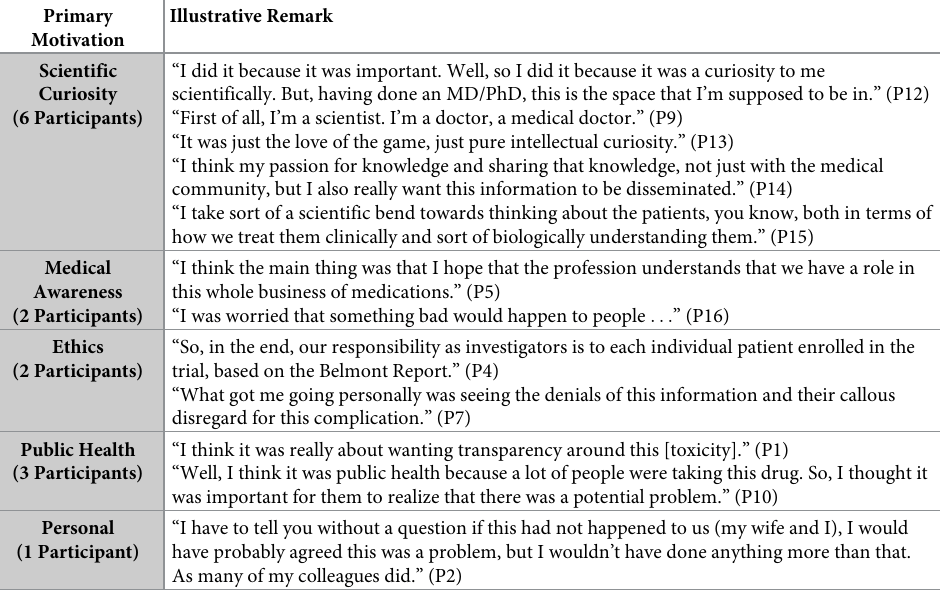
Table 2. Primary motivations for publishing adverse drug reactions.